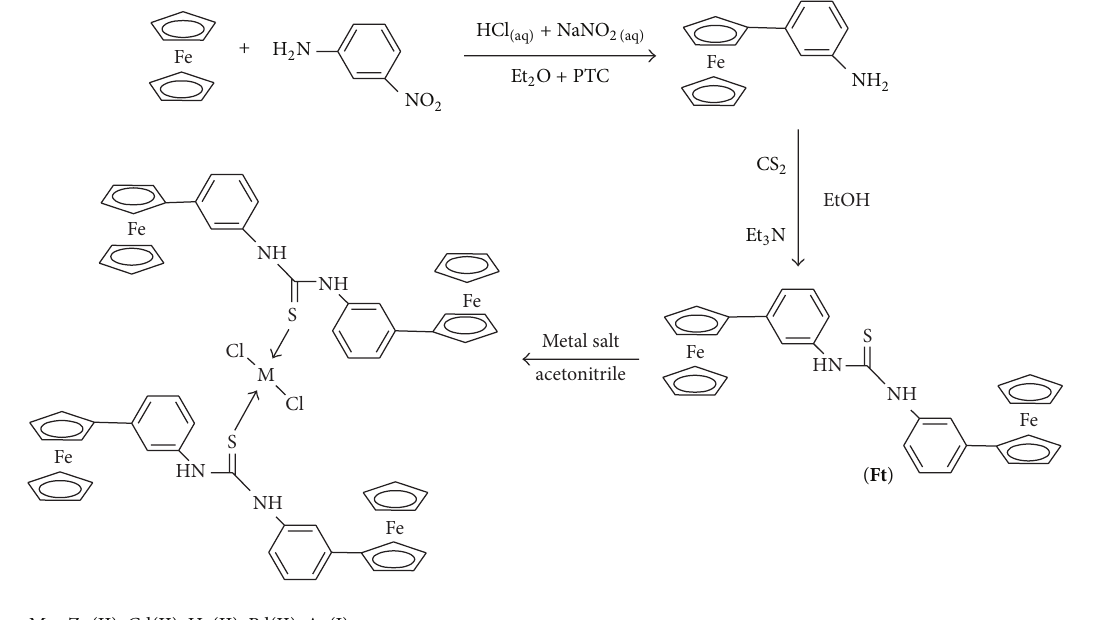
Scheme 1: Synthesis of ferrocene-based bimetallic thiourea